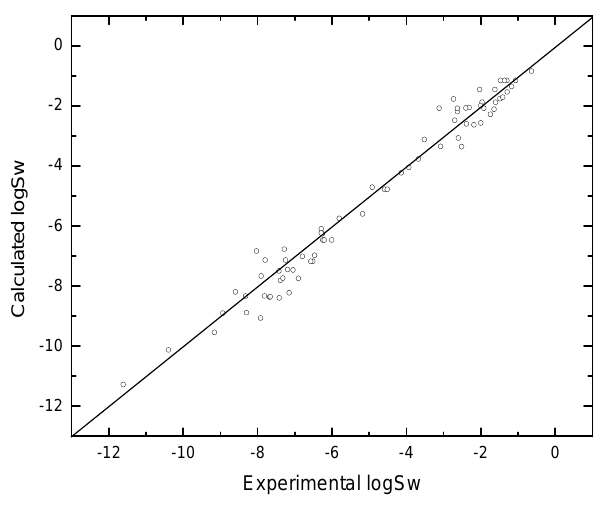
Figure 2. Calculated values versus experimental values of logSw for the testing data